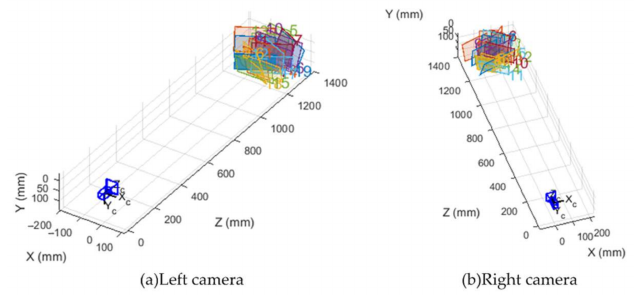
Figure 8. Calibration images of the left ( a ) and right ( b ) cameras.